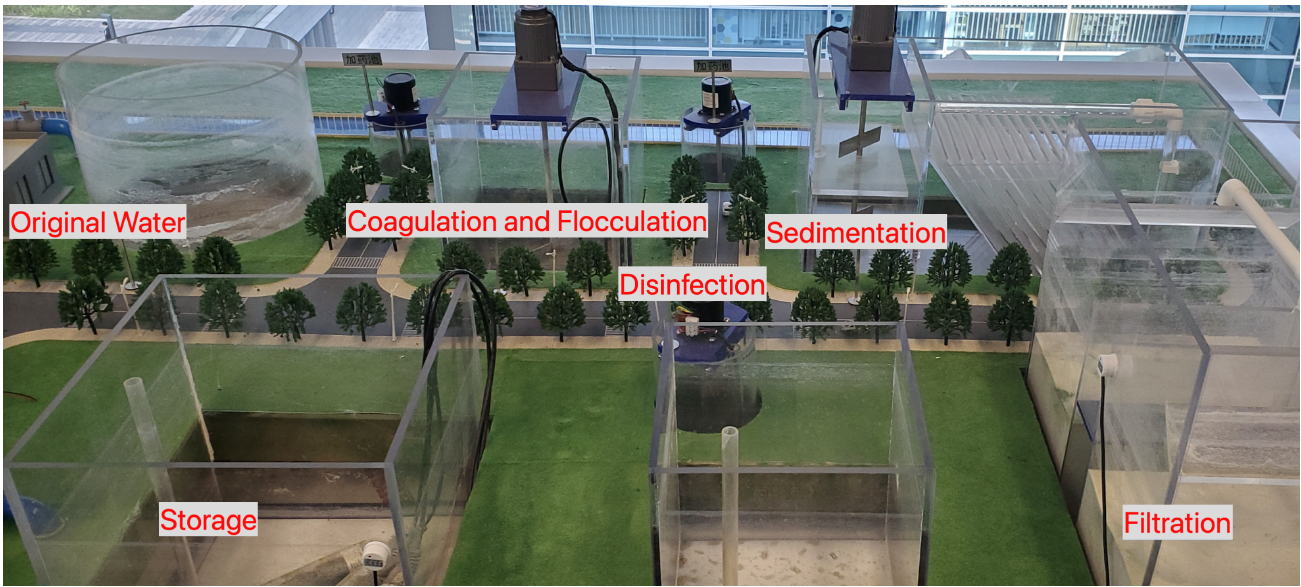
Figure 9. The Tap Water Treatment System.